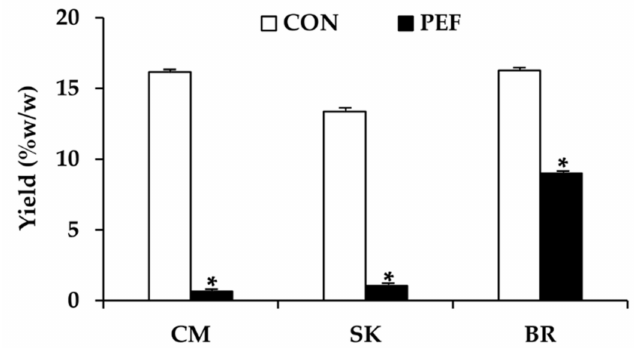
Figure 1. Yield of Morus alba leaf extract from Chiang Mai (CM), Sakon Nakon (SK), and Buriram (BR) when extracted using conventional maceration (CON) and pulsed electric field extraction (PEF). Asterisk (*) denotes significant di ff erence between CON and PEF, P <